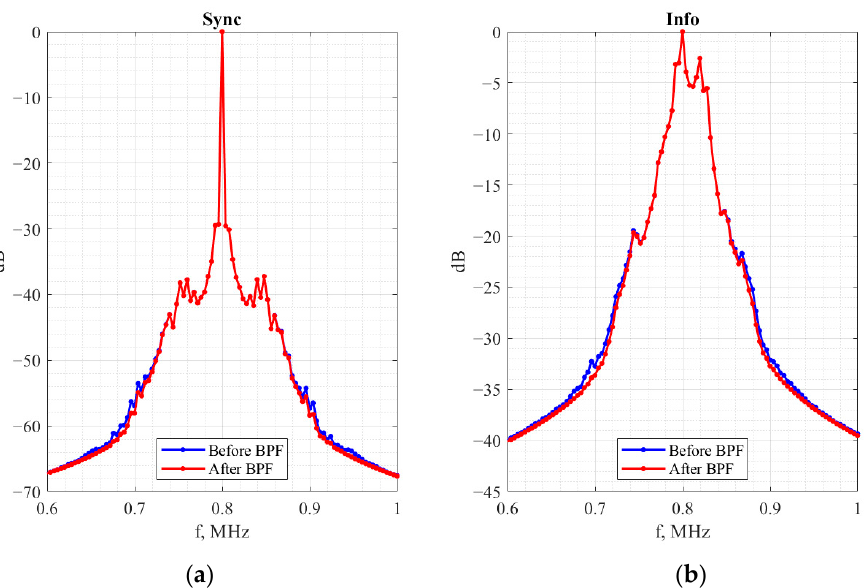
Figure 11. Frequency-modulated synchronization ( a ) and information-carrying ( b ) signals’ spectra for RC two-transistor oscillator-based FM-CSK communication system. Blue and red lines denote the signals before and after bandpass filters (BPF).